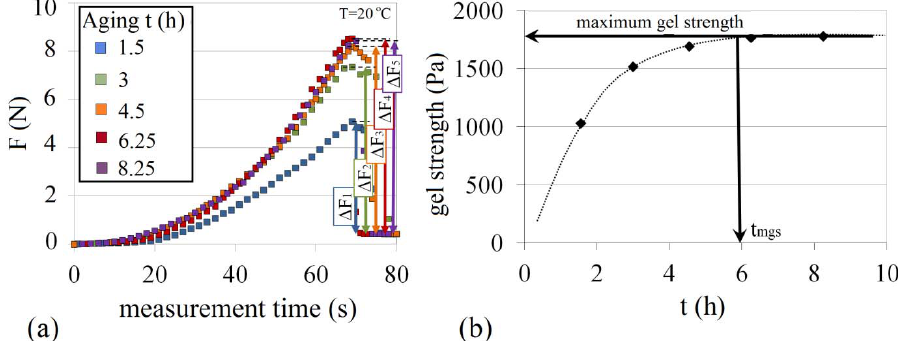
Figure 16. Gel strength measurements at different gel aging times for 6 wt% Na-silicate with a solution pH of 10.4: ( a ) measured force at various aging times of the gel; and ( b ) estimated gel strength at different times during the gelation